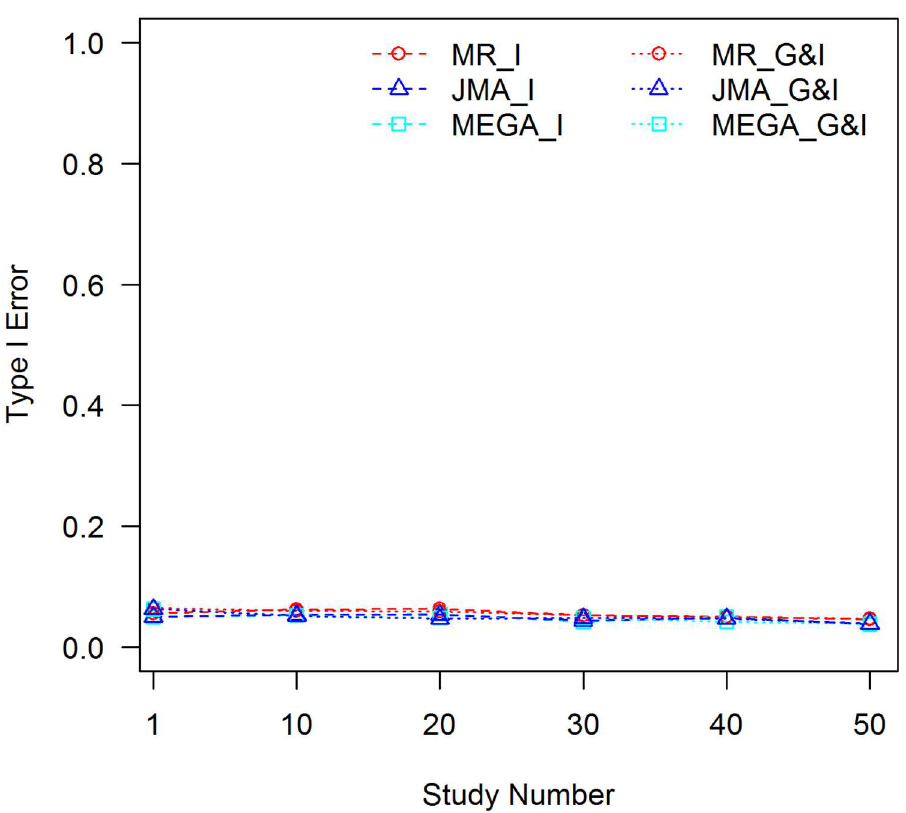
Fig 2. Tests of interaction without controlling for the C × E confounder, f 1 = f 2 = 0.3. MR_I: MR test of interaction; MR_G&I: MR joint test of the geneticmain effect and interaction; JMA_I: JMA test of interaction; JMA_G&I: JMA joint test of the genetic main effect and interaction;MEGA_I: mega-analysis test of interaction; and MEGA_G&I: mega-analysis joint test of the genetic main effect and interaction.